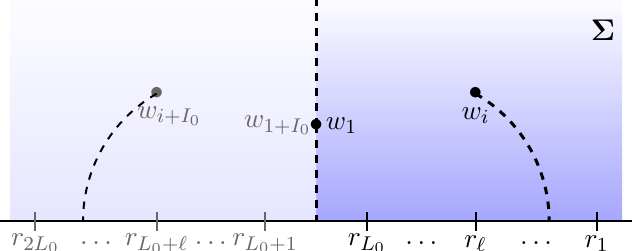
Figure 2. Upper half plane with symmetric arrangement of poles and punctures and two merged punctures at w = i . The branch cuts extending in opposite directions along the imaginary axis are mapped into each other by the Z 2 symmetry (2.14). The quotient solution can be taken as the right